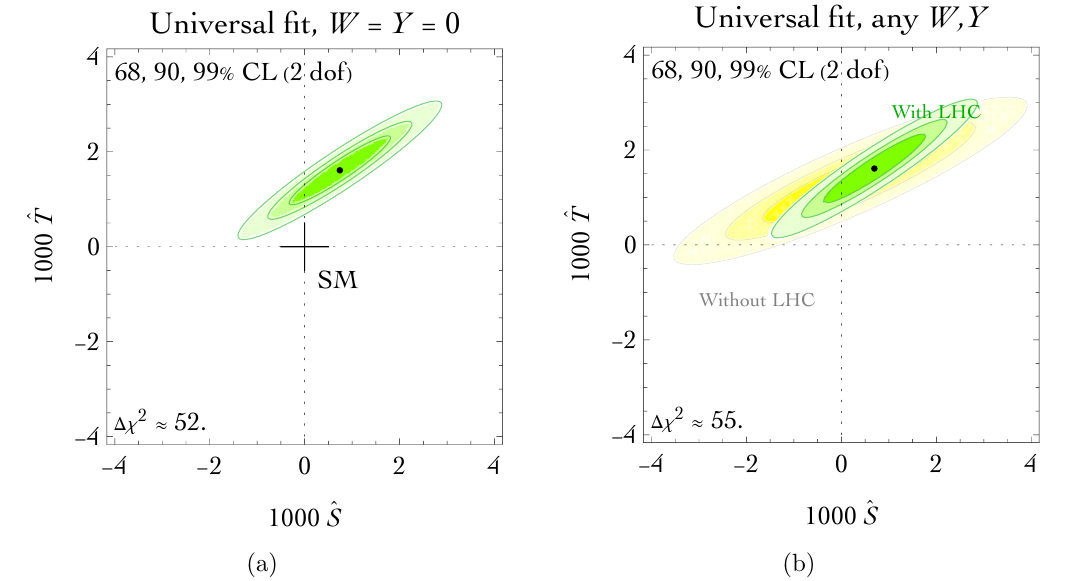
Figure 2. The green regions are favoured by our global fit of the universal b S, b T, W, Y electroweak parameters. The yellow regions shwow the analogous results computed without including the new LHC bounds on W, Y .